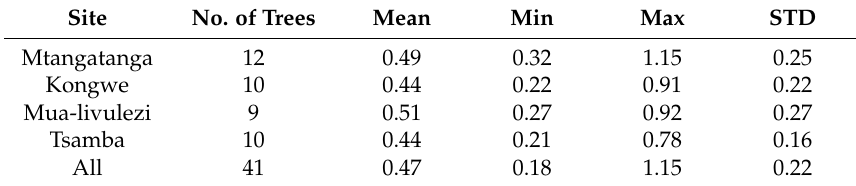
Table 4. Mean, standard deviation (STD) and range of root to shoot ratios (RS-ratio) over sites.